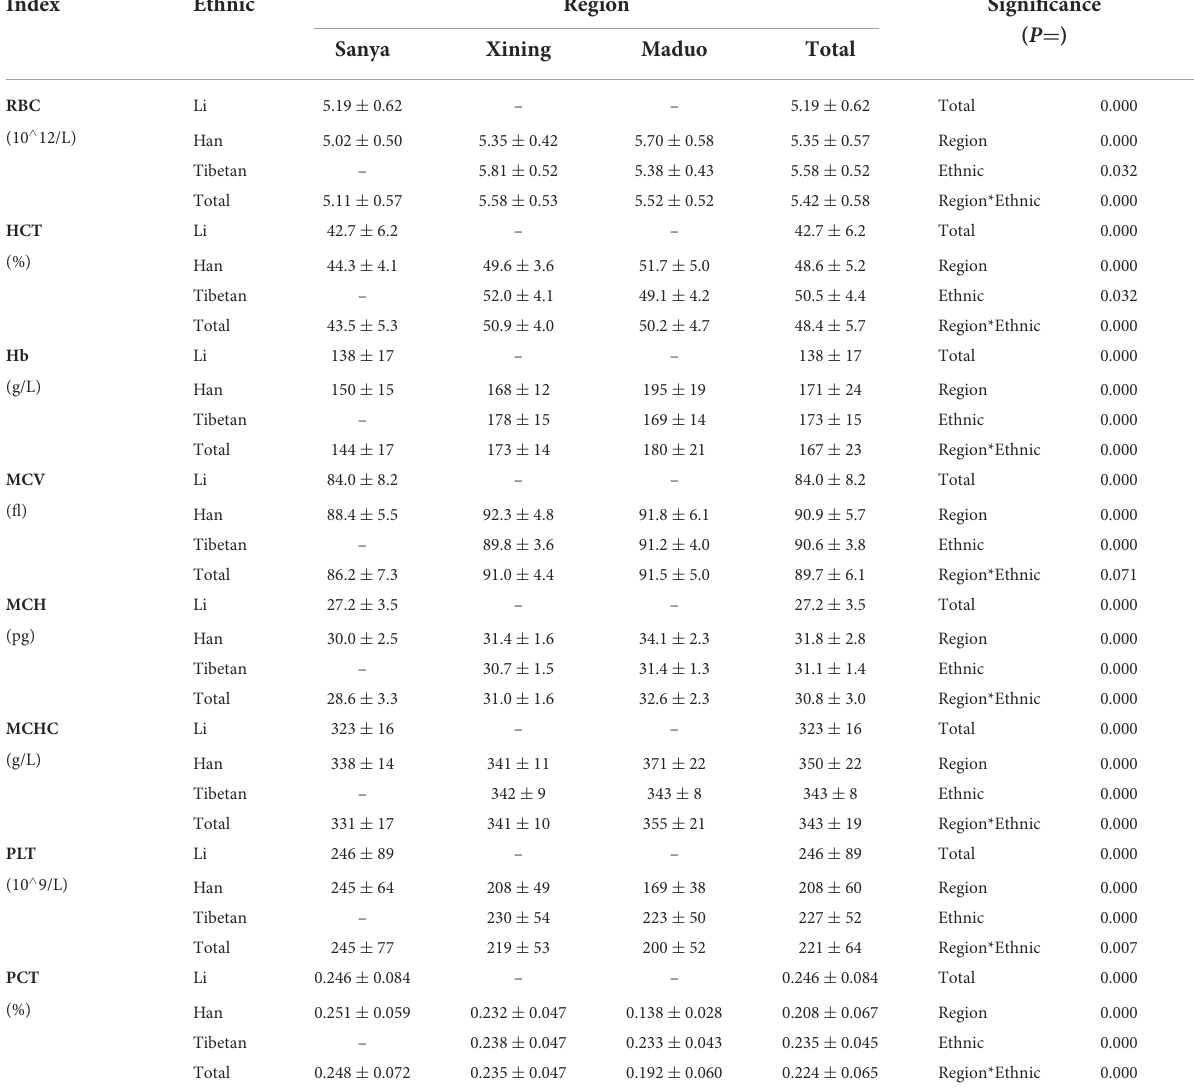
TABLE 4 RBT results of the enrolled population ( x ± s )